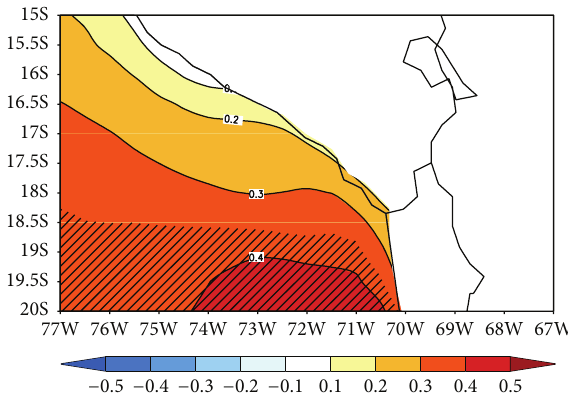
Figure 10: JJA correlation of EIS index with CFS reanalysis pre- cipitable water shaded and contoured (data from 1979 to 2009). Hatched areas are significant at a 90% level for a 2-tailed